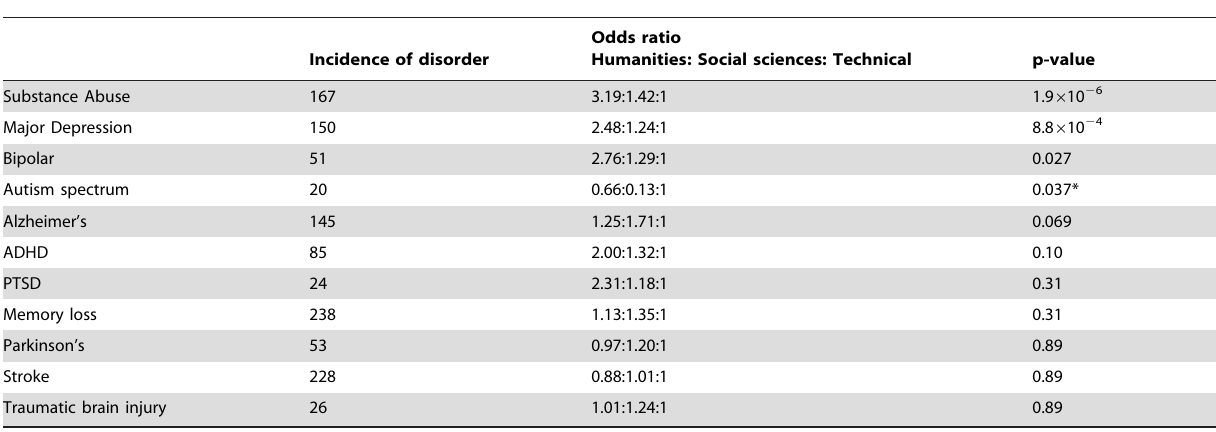
Table 1. Relationships between neuropsychiatric disorders and intended academic major.